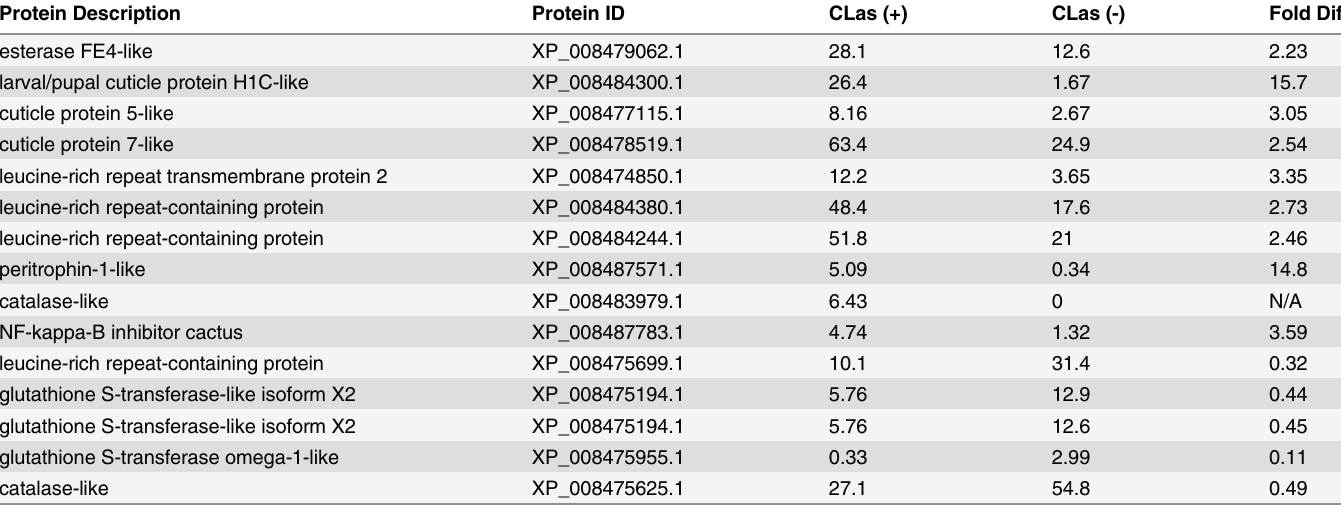
Table 3. Selected D . citri defense and immunity proteins differentially expressed between CLas(+) and CLas(-) insects. Average normalized peptide count from specified proteins and fold difference: